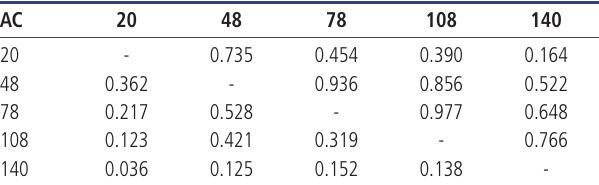
Table 3. Phenotypic correlation (lower diagonal) and genetic correlation (upper diagonal) among different ages at calving in LE33het10 model